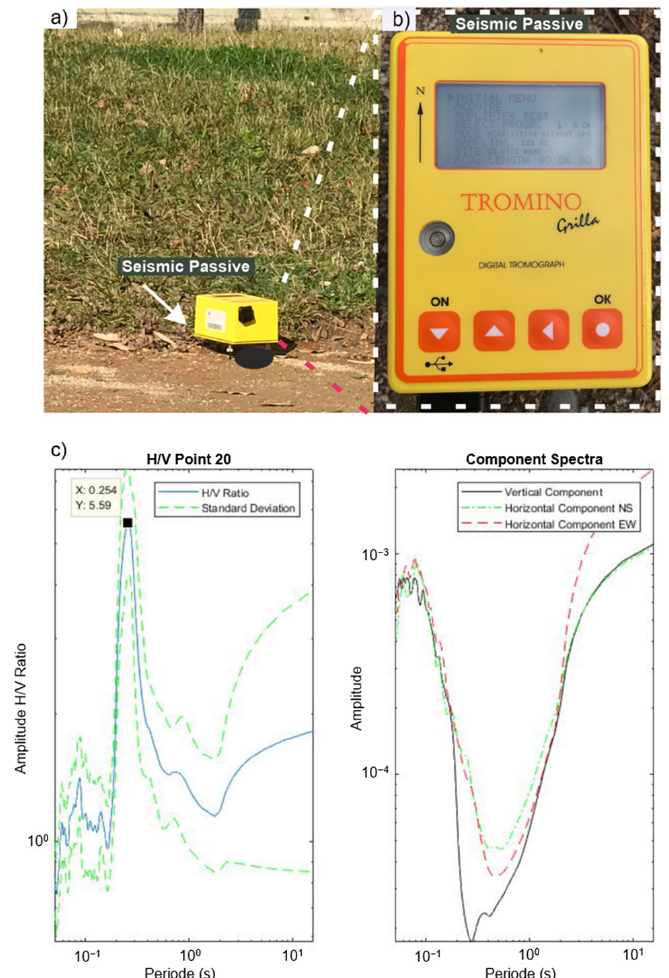
Figure 8. Passive Seismic Interferometry method. ( a ) Seismic passive test on site, ( b ) display screen of seismic passive test, and ( c ) seismograph.